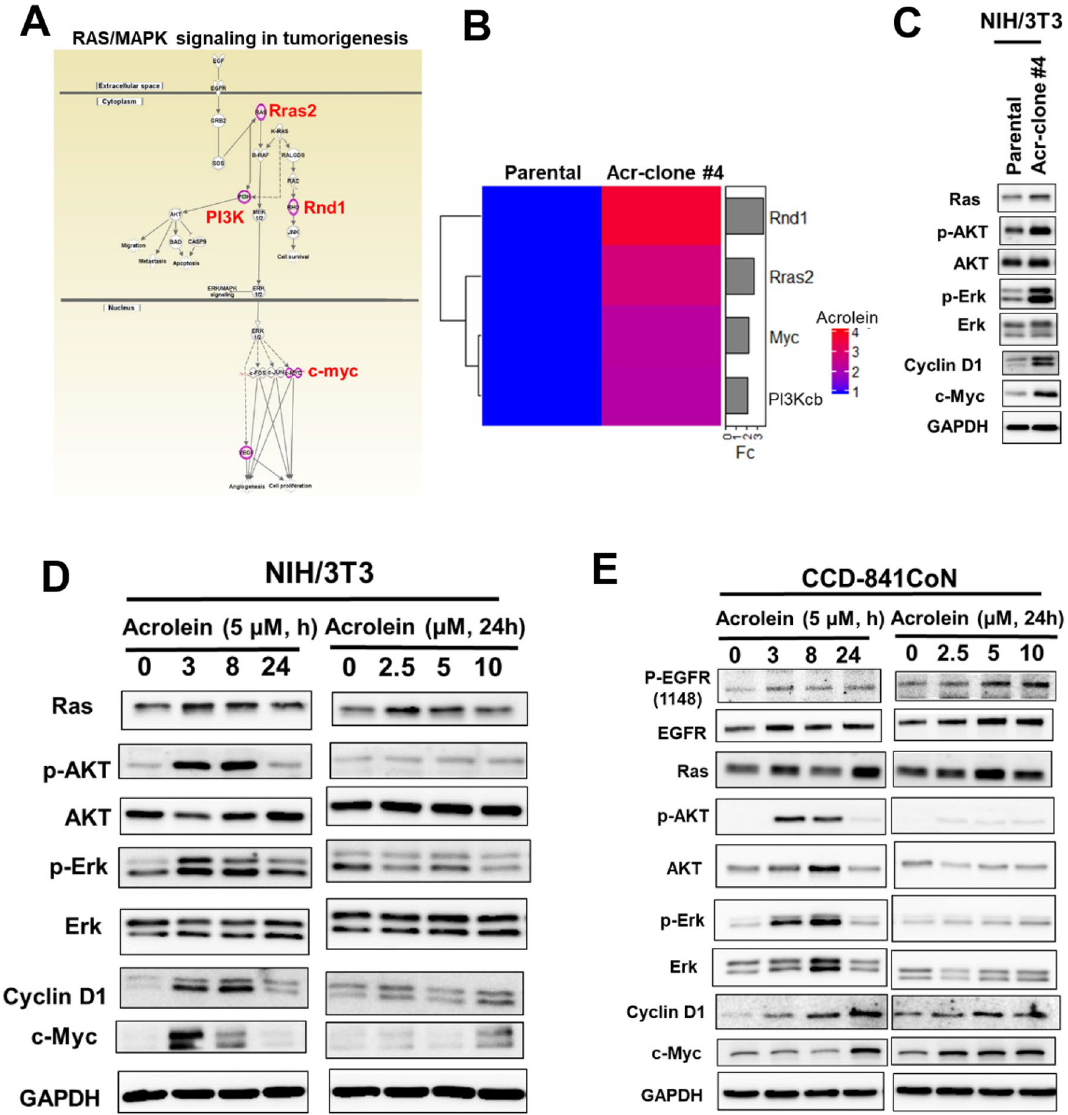
Figure 3. Ingenuity Pathway Analysis (IPA) of gene expression profiles in acrolein-transformed clones. (A) Bioinformatic analysis of the differentially expressed genes (DEGs, fold change ≥ 2) was performed using IPA, and canonical pathway analysis for gene expression profiles in acrolein-transformed clone #4 (Acr-clone #4) is shown. (B) Heatmap of 4 genes (Rnd1, Rras2, Myc and PI3Kcb) in acrolein-transformed clone #4 compared to parental NIH/3T3 cells. FC, fold-change, indicates RNA expression fold change between NIH/3T3 Acr-clone#4 and parental cells. (C) Western blot analysis of the RAS/ERK and AKT pathways in acrolein-transformed clone #4 compared to parental NIH/3T3 cells. (D,E) Dose and time effects of acrolein on RAS expression, AKT activation, ERK activation, cyclin D1 and c-myc expression in NIH/3T3 cells (D) and CCD-841CoN cells (E) were analyzed using Western blot analysis. For dose and time effects, cells were treated with different concentrations of acrolein (0–10 μM) for 24 h or acrolein (5 μM) for 3–24 h, respectively. Original Western blots of (C–E) are shown in Supplementary Fig.